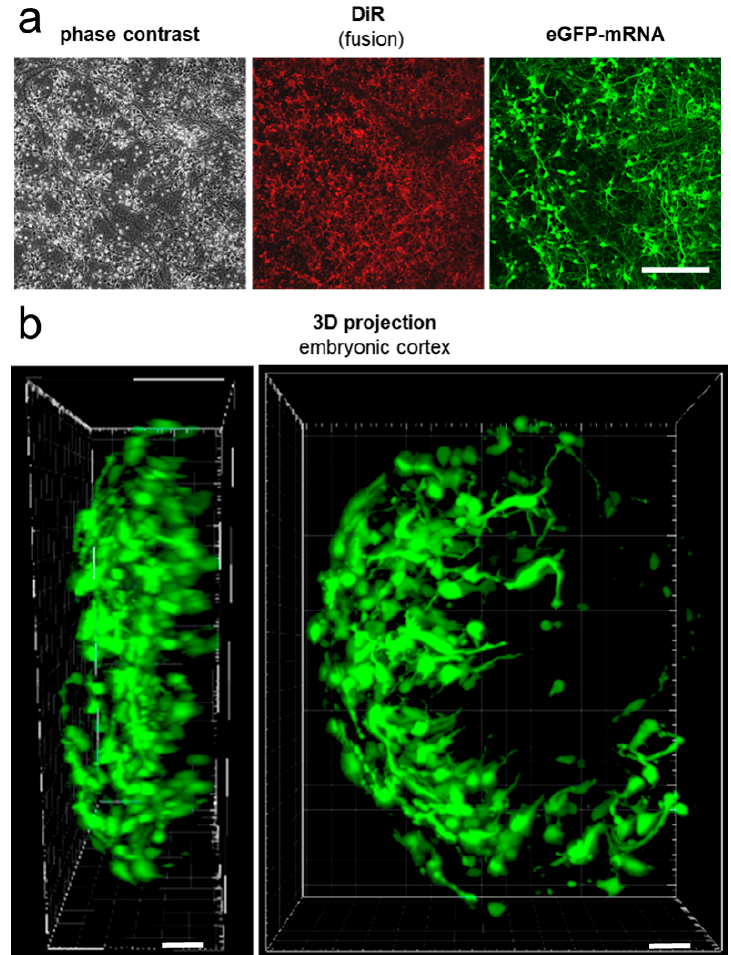
Figure 6. eGFP–mRNA transfer into primary neuronal cells and primary cortical tissue using FLs. Fluorescence and phase contrast micrographs of primary rat cortical neurons six days after treatment with protamine/eGFP–mRNA/FLs ( a ). 3D reconstruction of rat embryonic cortex based on eGFP fluorescence. eGFP–mRNA was delivered by FLs 6 days before analysis ( b ). Scale bars 200